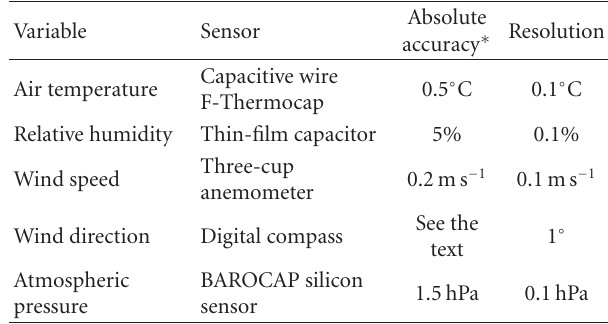
Table 1: Vaisala DigiCORA TT12 tethersonde sensors with accura- cies and